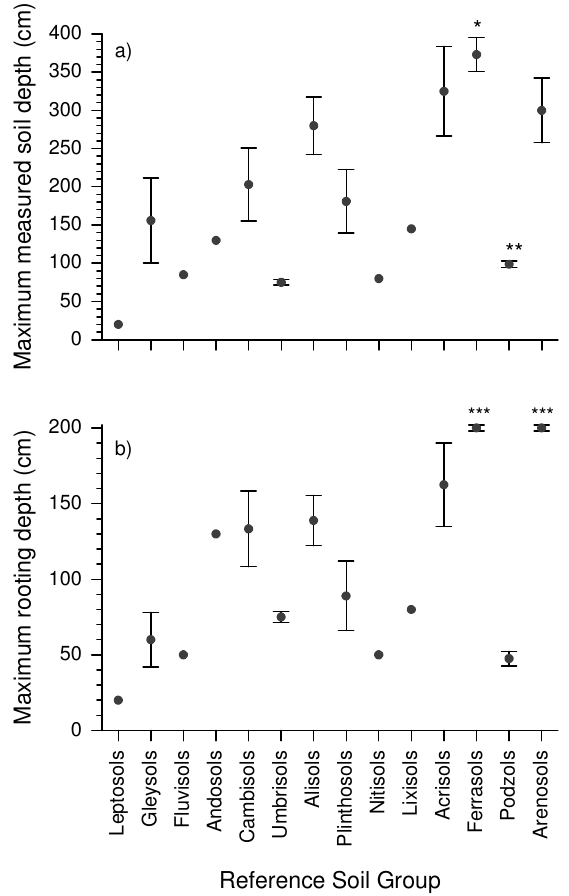
Fig. 22. Changes in soil and root depth in Amazonia following the soil development gradient. (a) maximum soil depth and (b) maxi- mum root depth. ∗ Ferralsols were often deeper than 4m, they are often reported to reach depths greater than 10m. ∗∗ Does not reflect actual soil depth as sampling usually stoped at saturated layers. ∗∗∗ Maximum depth measured was 2.0m, some roots may be deeper than that. structure, dynamics and composition (Quesada et al., 2009). Soil depth (defined here as depth to rock or saprolite con- tact) is another characteristic associated with pedogenetic stage. In general terms, soils tend to increase in depth fol- lowing weathering, with Leptosols varying from as little as 0.2 m deep to more than 4 m in the Ferralsols (Fig. 22a). Nev- ertheless, some variation in this trend is expected to